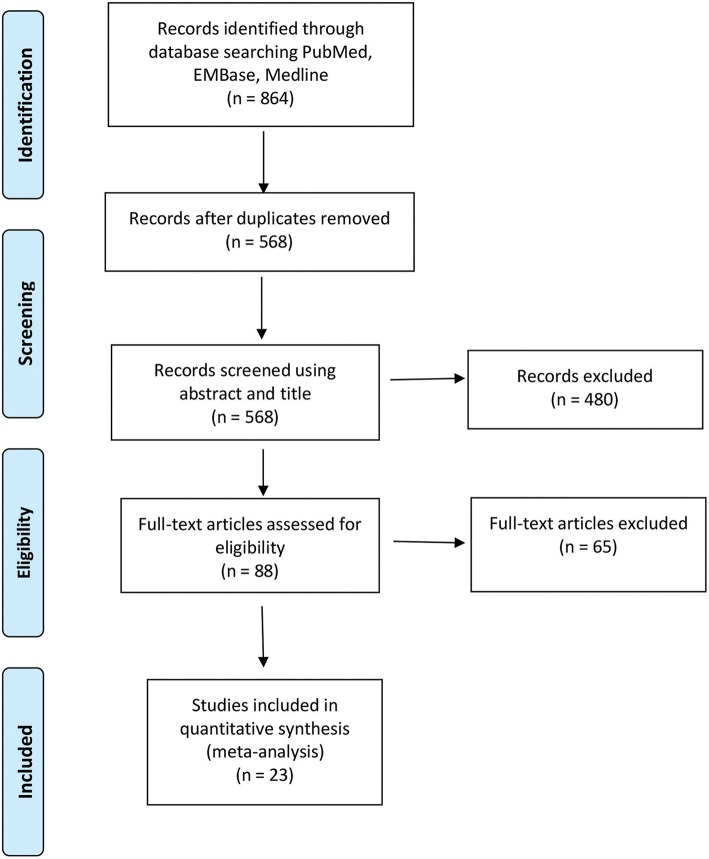
Preferred Reporting Items for Systematic Reviews and Meta-Analyses (PRISMA) flow diagram of the studies included in the meta-analysis of resection and survival outcomes among patients with 5-aminolevulinic acid–guided resection of high-grade glioma. Used with permission from Barrow Neurological Institute, Phoenix, Arizona.